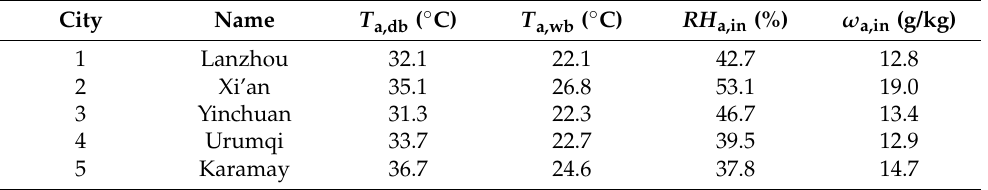
Table 2. Outdoor air design conditions for summer air conditioning of each city.